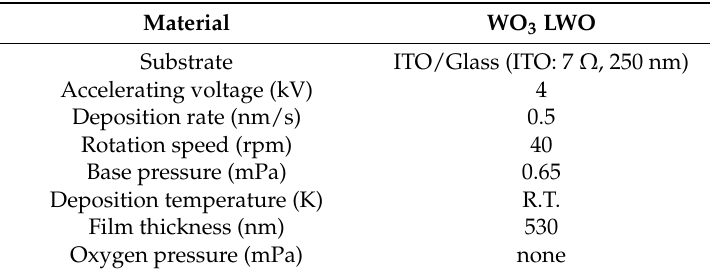
Table 2. The deposition parameters of electrochromic